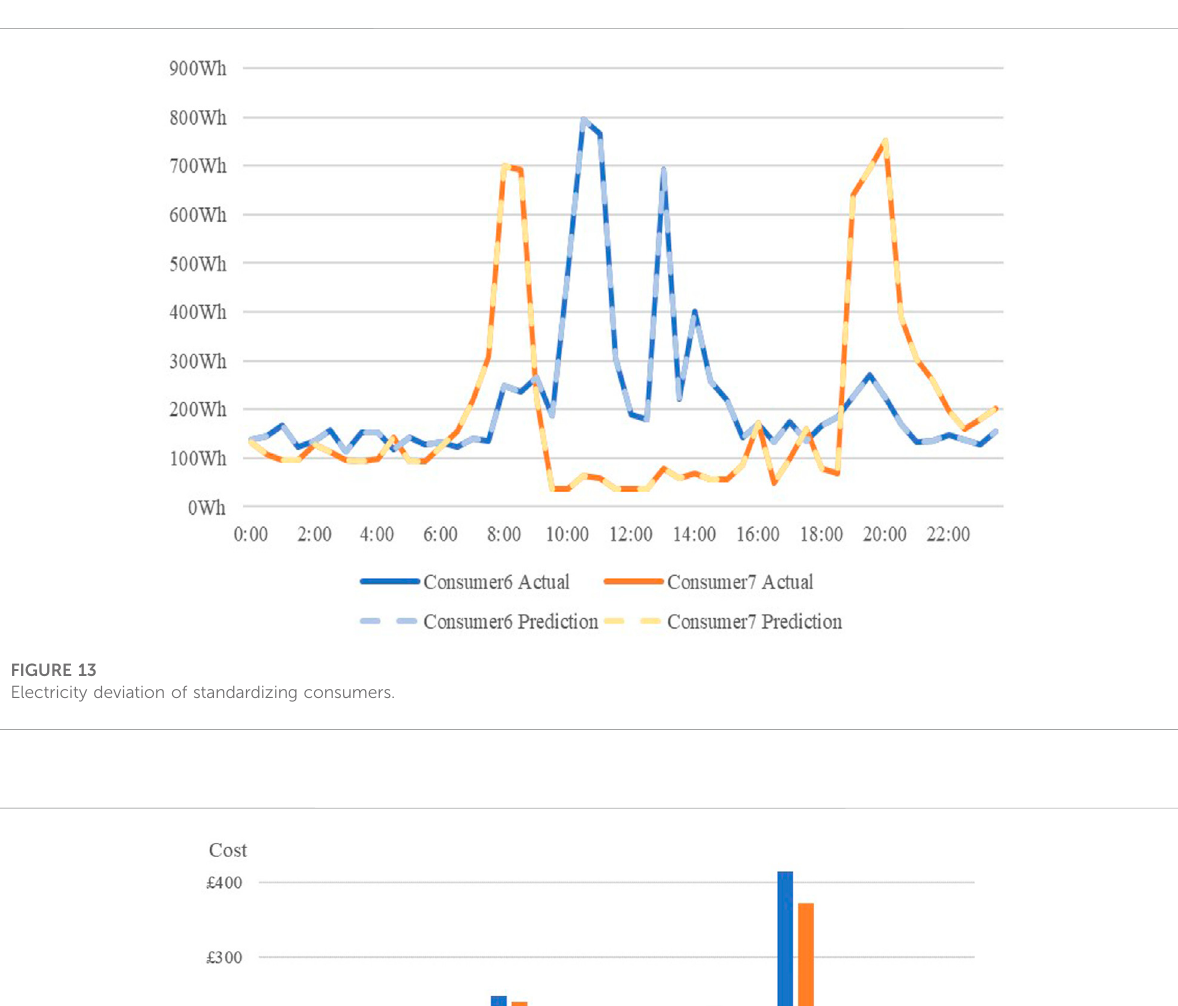
FIGURE 14 Daily energy consumption of each